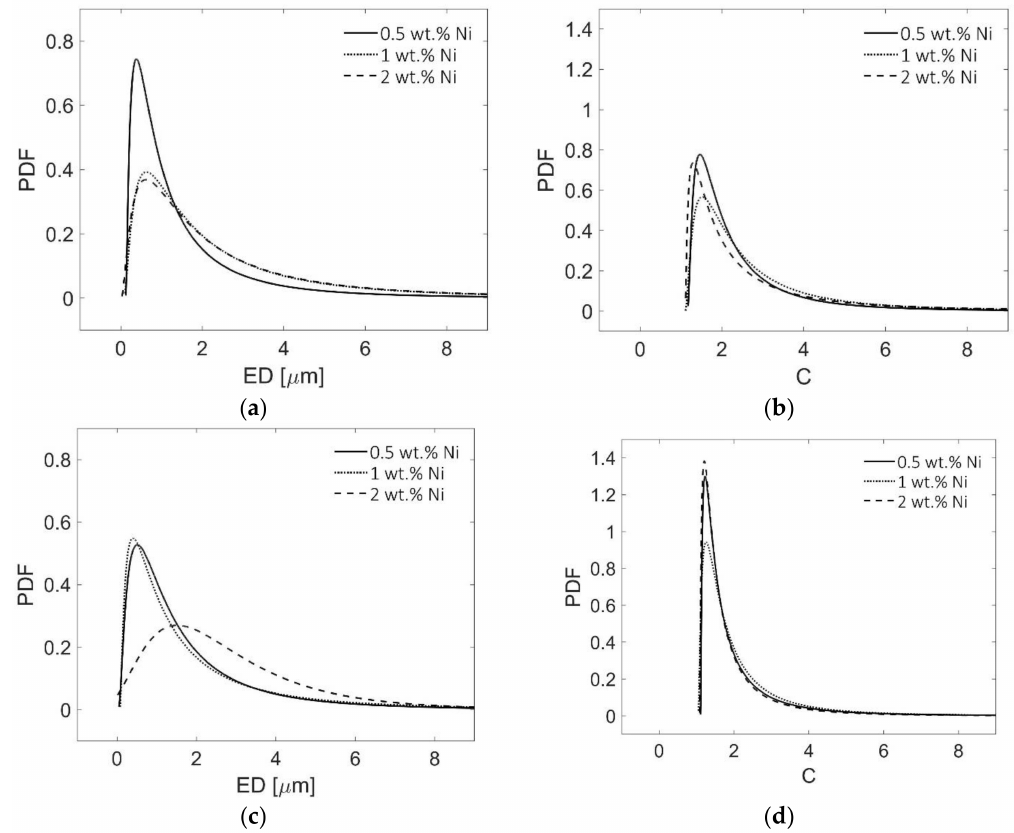
Figure 7. Distributions of geometrical parameters of Ni-based compounds: ( a ) ED, as-cast condition; ( b ) C, as-cast condition; ( c ) ED, T6 heat-treated condition; and ( d ) C, T6 heat-treated condition.